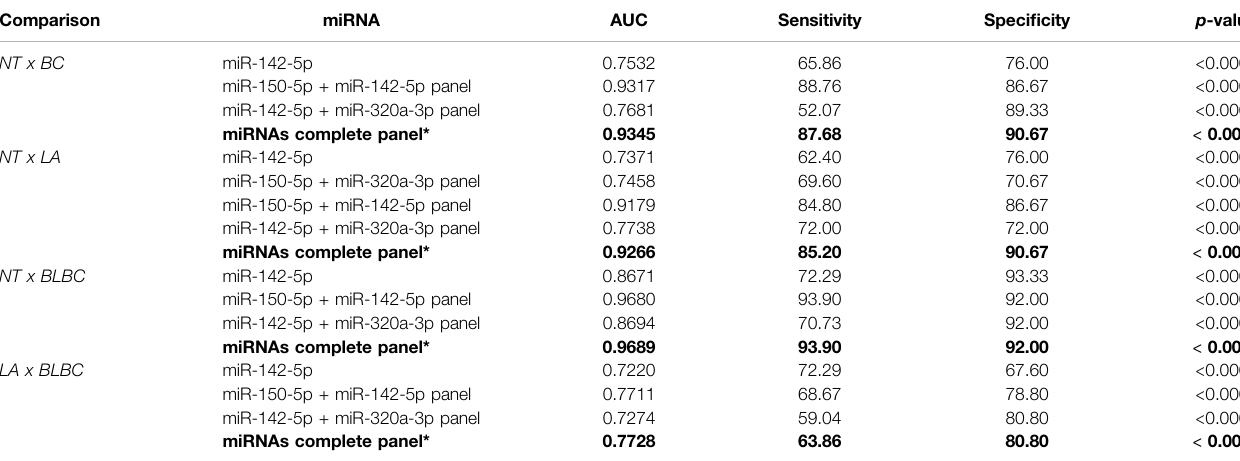
TABLE 3 | Data about receiver operating characteristic (ROC) curves to investigate the diagnostic potential of miRNAs on TCGA samples. Comparison miRNA